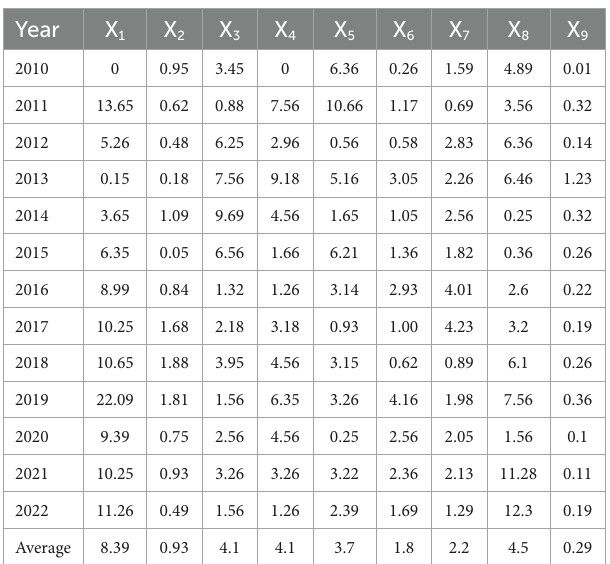
TABLE 6 Relative errors of independent variables